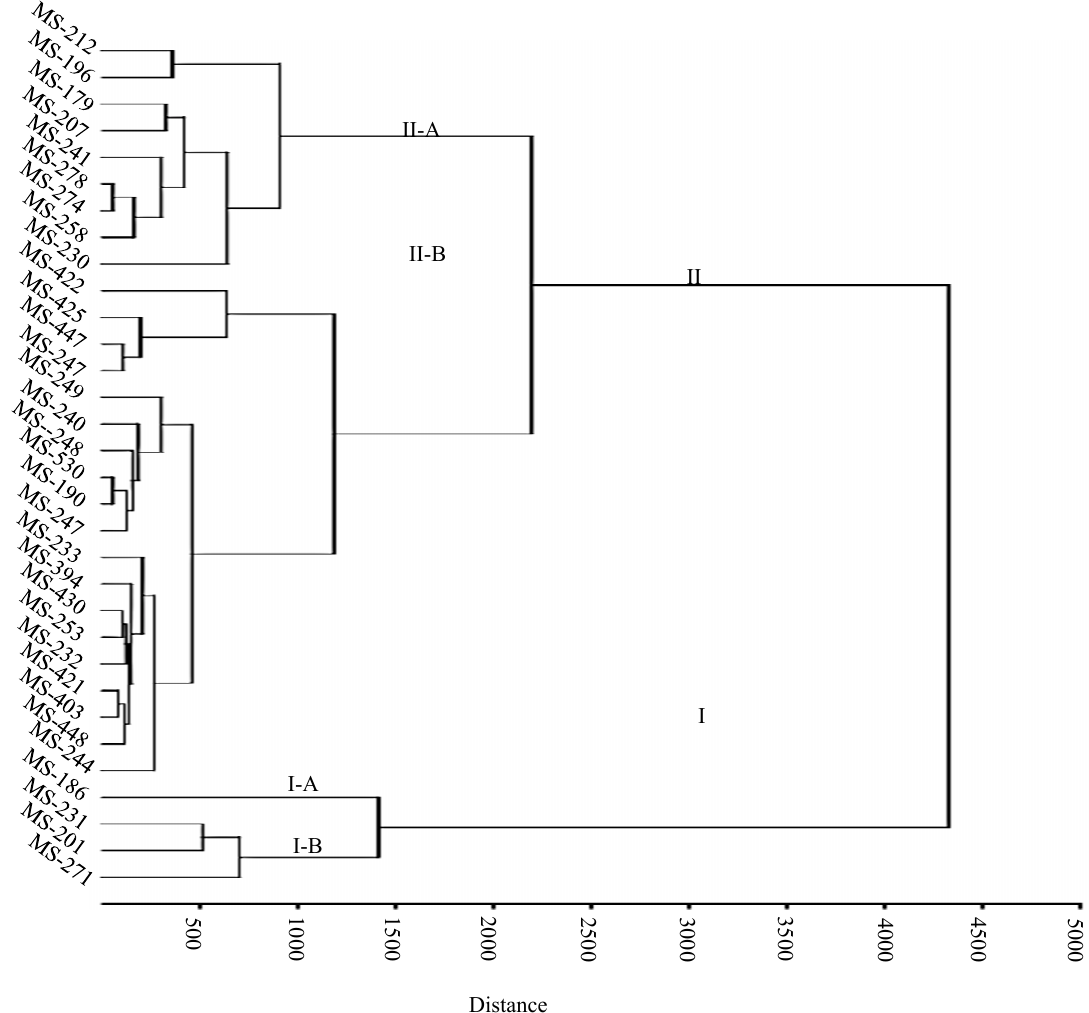
Figure 2. Dendrogram of morphological traits using unweighted pair group method with arithmetic mean (UPGMA) clustering in the selected accessions of M. sacchariflorus grown in the field.